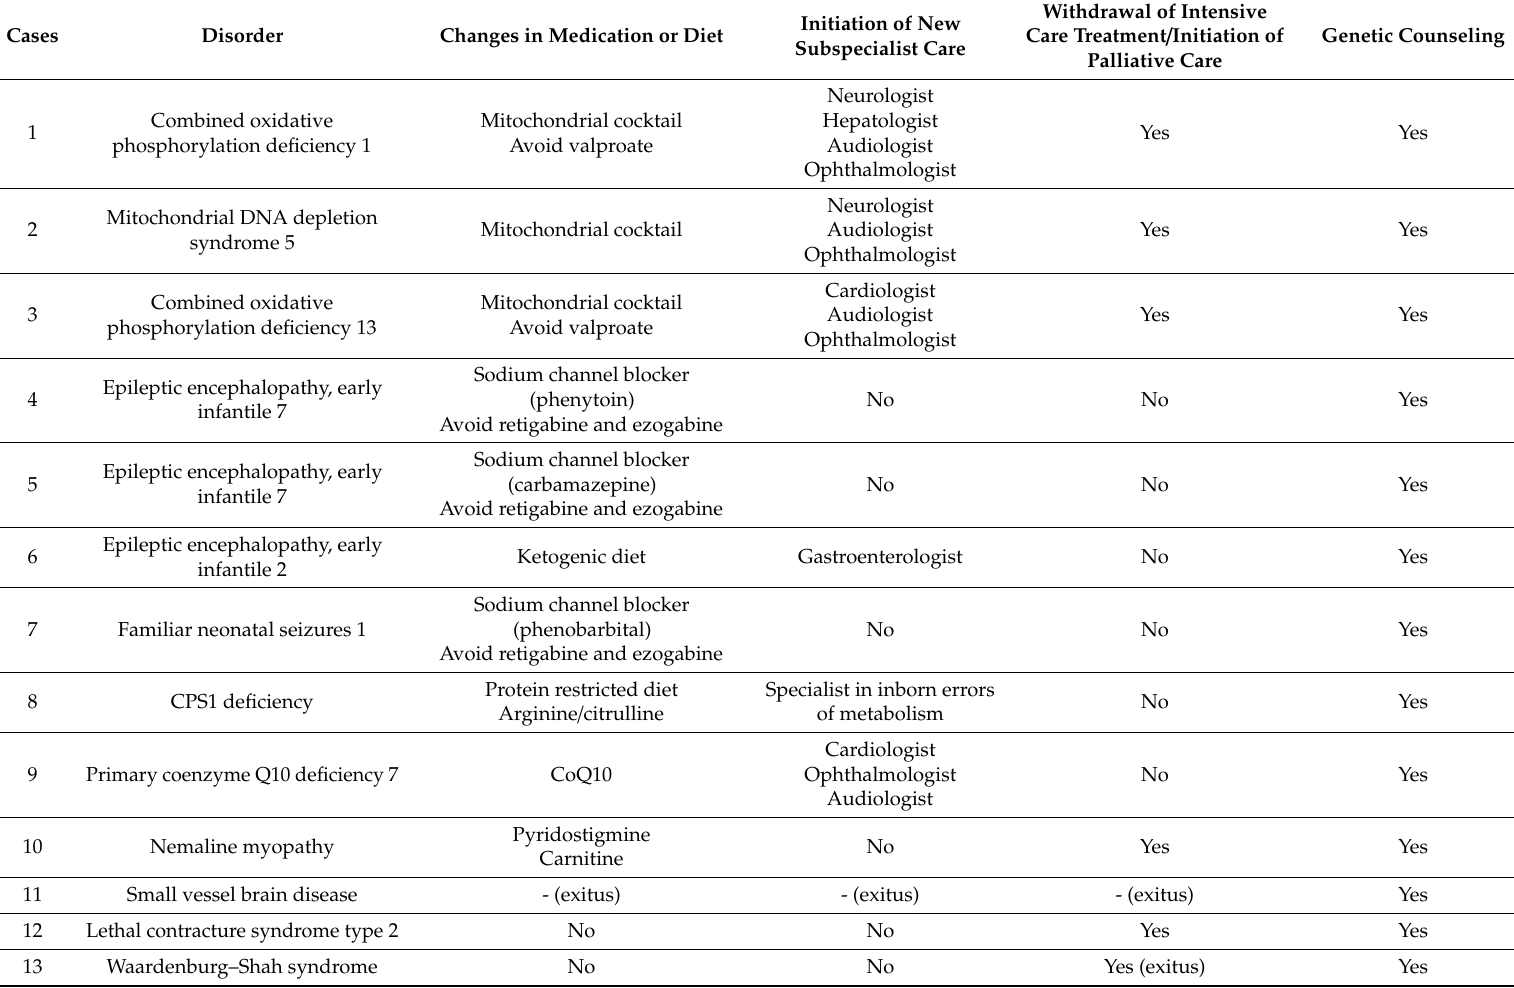
Table 3. Impact of molecular diagnosis on medical